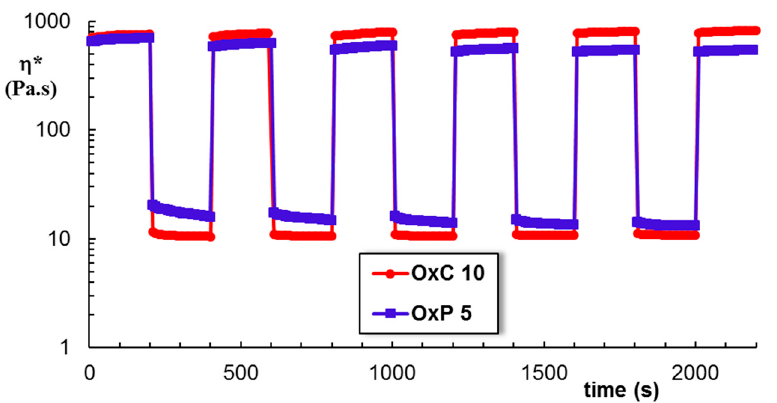
Figure 7. Self-healing behavior of OxC 10 and OxP 5 hydrogels when successive strains of 1% and 400% were applied ( ω = 1 rad/s, 25 °C).